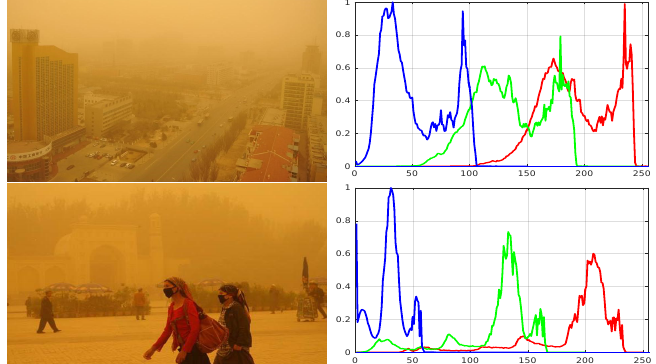
Figure 3. Sand dust images and